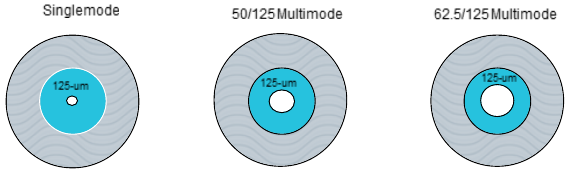
Figure 1. Schematic of optical fiber based on the core diameter and mode.